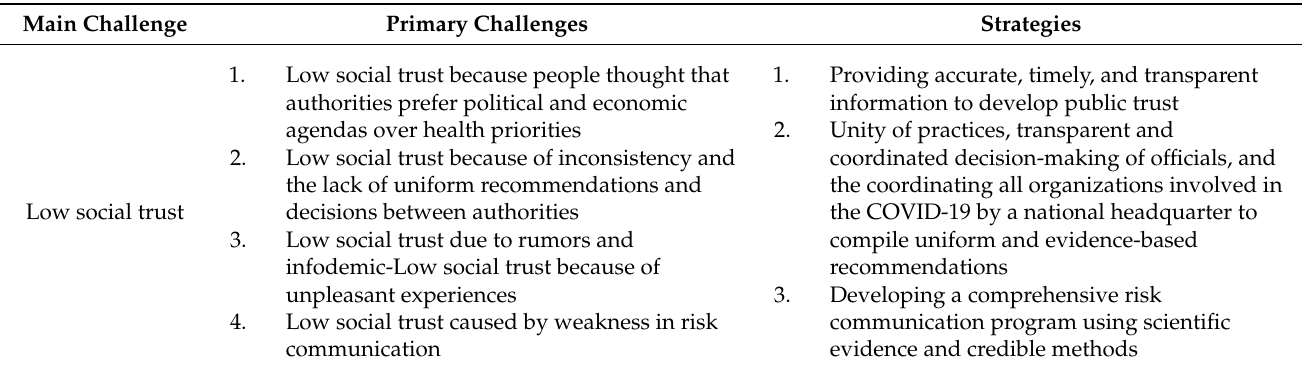
Table 5. Challenges and Strategies for Accepting Vaccines Based on the Experiences and Perceptions of Different Iranian Groups. Main